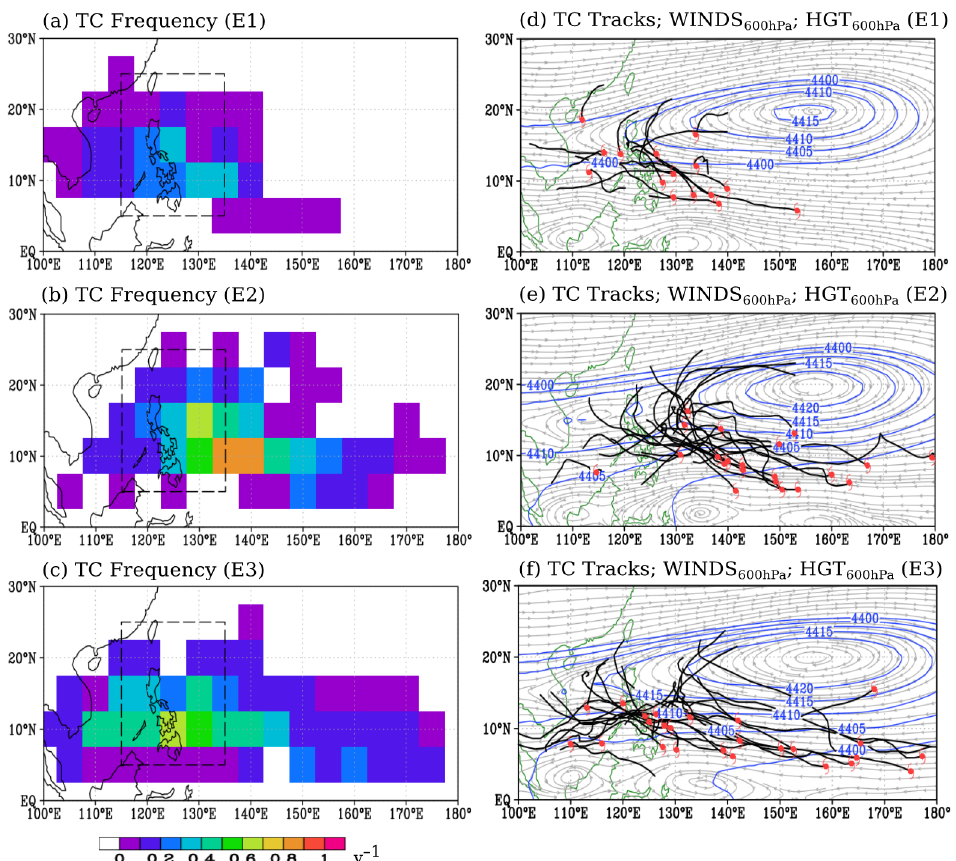
Figure 7. Tropical cyclone (TC) track frequency (y − 1 ) interpolated onto a 5 ◦ × 5 ◦ grid during December, TC tracks (black lines), 600-hPa winds ( WINDS 600hPa ; grey streamlines; m s − 1 ), and 600-hPa geopotential height ( HGT 600hPa ; blue contours; m) for: E1 (1961–1976; a , d ); E2 (1977–1992; b,e ); and E3 (1993–2008; c , f ) based on the Joint Typhoon Warning Center (JTWC) track dataset. Dashed boxes from ( a ) to ( c ) indicates the Philippine Area of Responsibility (PAR; 115 ◦ to 135 ◦ E and 5 ◦ to 25 ◦ N). The TC genesis locations from ( d ) and ( f ) are indicated by the red markings.